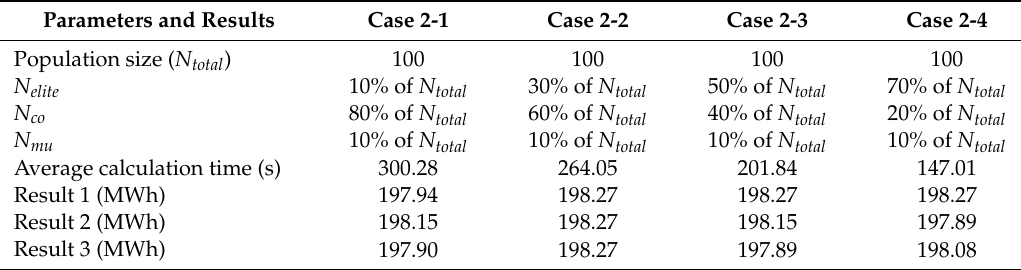
Table 5. Convergence and calculation time according to the crossover